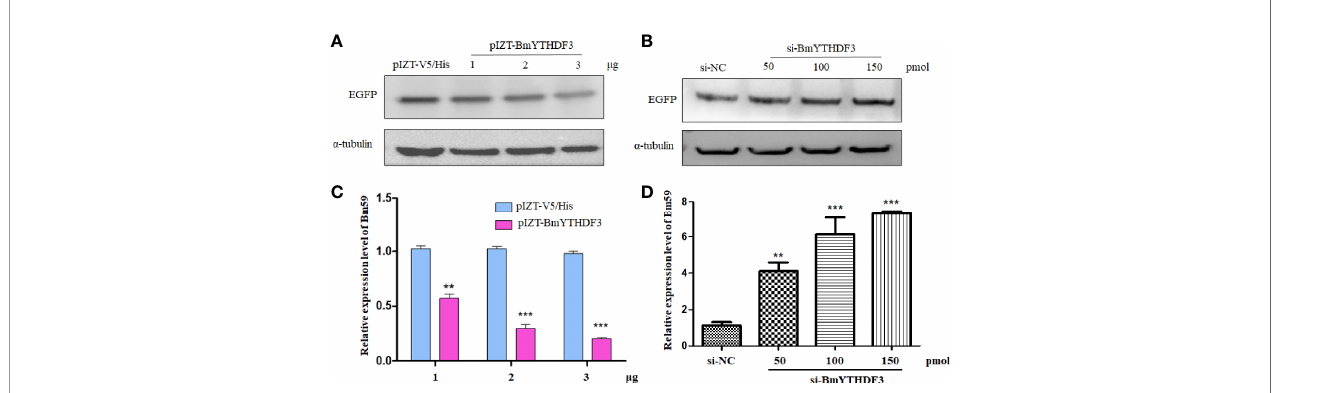
FIGURE 5 | Knockdown of BmYTHDF3 suppressed BmNPV infection and replication. (A) The infection of BmNPV in BmN cells transfected with pIZT-BmYTHDF3 (1, 2, and 3 m g) or pIZT-V5/His as control following BmNPV-GFP infection was detected by Western blotting. (B) The infection of BmNPV in BmN cells transfected with si-BmYTHDF3 (50, 100, and 150 pmol) or si-NC as control following BmNPV-GFP infection was detected by Western blotting. (C) The relative expression level of Bm59 in BmN cells transfected with pIZT-BmYTHDF3 (1, 2, and 3 m g) or pIZT-V5/His as control following BmNPV-GFP infection was detected by real-time PCR. (D) The relative expression level of Bm59 in BmN cells transfected with si-BmYTHDF3 (50, 100, and 150 pmol) or si-NC as control following BmNPV-GFP infection was detected by real-time PCR. ** p < 0.05 and *** p <